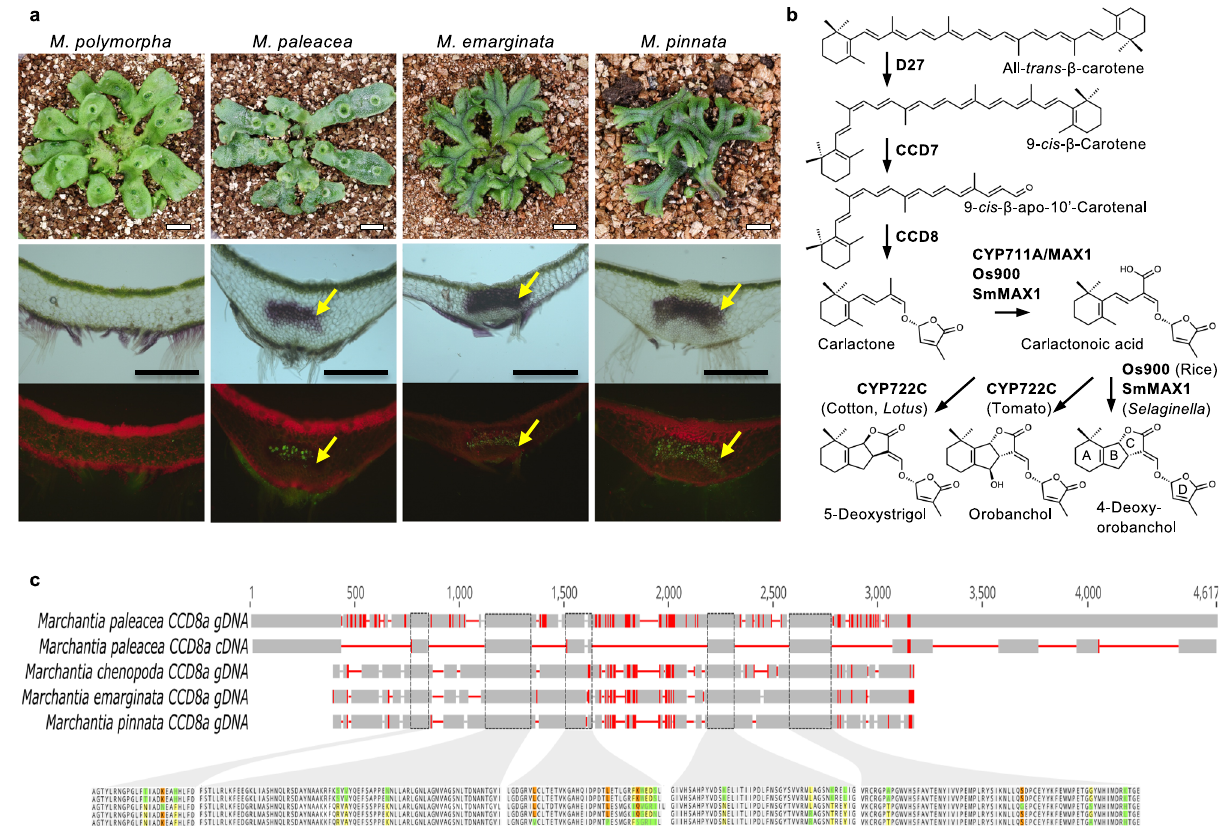
Fig. 1 Presence of SL biosynthesis genes is speci fi c to AM symbiosis-forming species in Marchantia . a Marchantia species, namely Marchantia polymorpha, Marchantia paleacea , Marchantia emarginata and Marchantia pinnata , used in this study. Upper panels show plant morphology. Scale bars: 1 cm. Middle and lower panels are transverse sections after colonization by Rhizophagus irregularis . The lower panel shows WGA-FITC staining of the fungi. Arbuscules are formed in the midrib region in the thallus (arrows). Experiment was repeated three times with similar results. Scale bars: 0.5 mm. b Biosynthesis pathway for strigolactones in seed plants and lycophytes. c Conservation of the CCD8A genes in mycorrhizal Marchantia species. Ampli fi ed sequences of CCD8A are aligned against the Marchantia paleacea gene model. Red lines indicate polymorphisms. The predicted amino acid sequences in the conserved domains are shown below the gene model. Polymorphic amino acids are colored. Equivalent amino acids present in one/two, three or four sequences are colored in green, yellow and orange